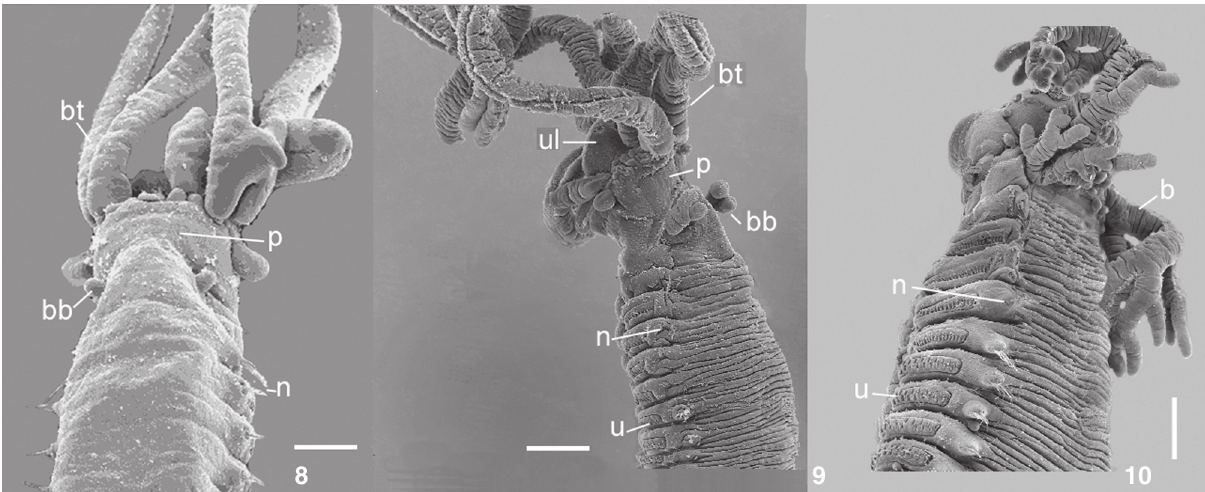
Figures 8-10. Nicolea uspiana , SEM micrographs illustrating the ontogenetic development: (8-9) juvenile specimens; (10) adult speci- men. (b) Branchia, (bb) branchial bulb, (bt) buccal tentacles, (n) notopodia, (p) prostomium, (u) uncini, (ul) upper lip. Scale bar: 8 = 0.2 mm, 9 = 0.15 mm, 10 = 0.1